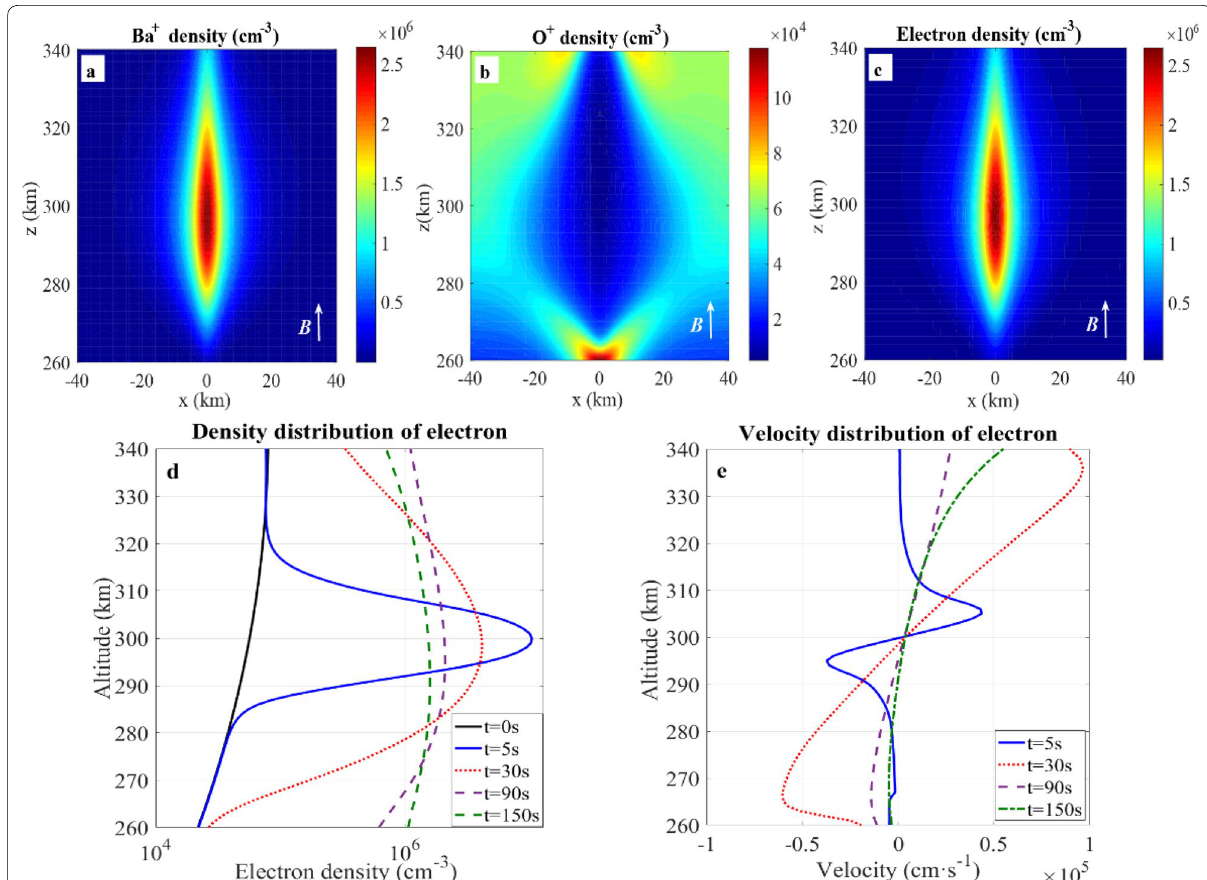
Fig. 4 The plasma cloud distribution in the x – z plane (at t distribution of electron density and velocity over height at different times ( d , e ). The maximum densities at t 1.05